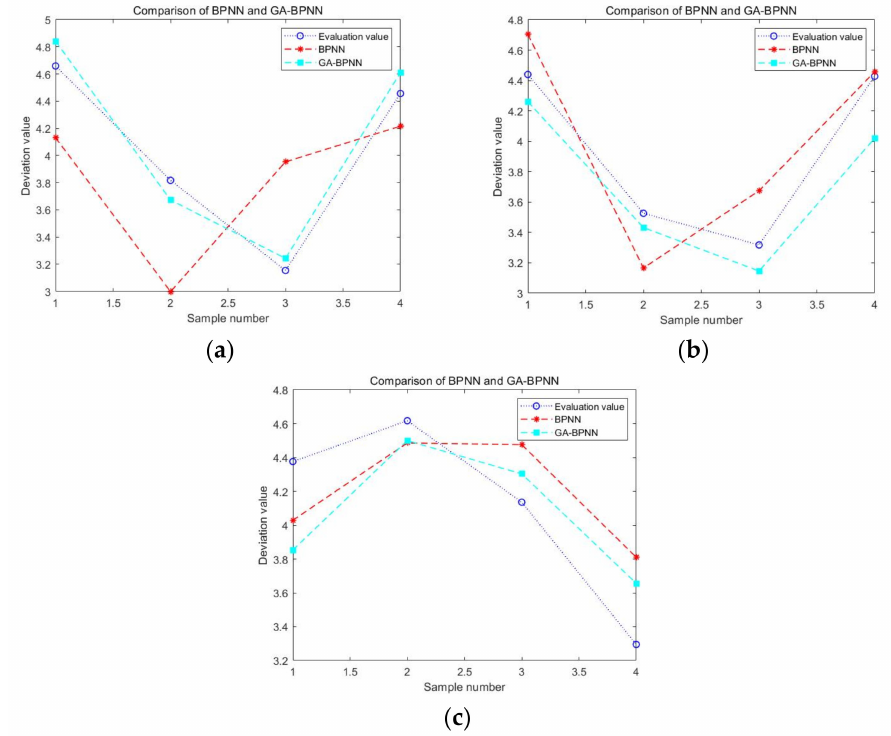
Figure 13. Predicted results for ( a ) “Annoyance-Comfortable”, ( b ) “Inexpensive-Premium”, and ( c ) “Weak-Powerful” of Kansei